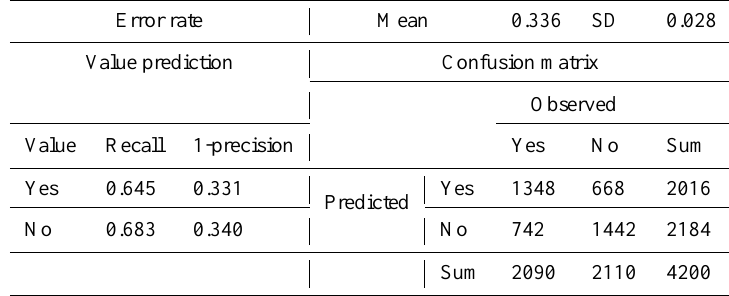
Table 1. Value prediction and confusion matrix of cross-folded validation for the 2007 data set.